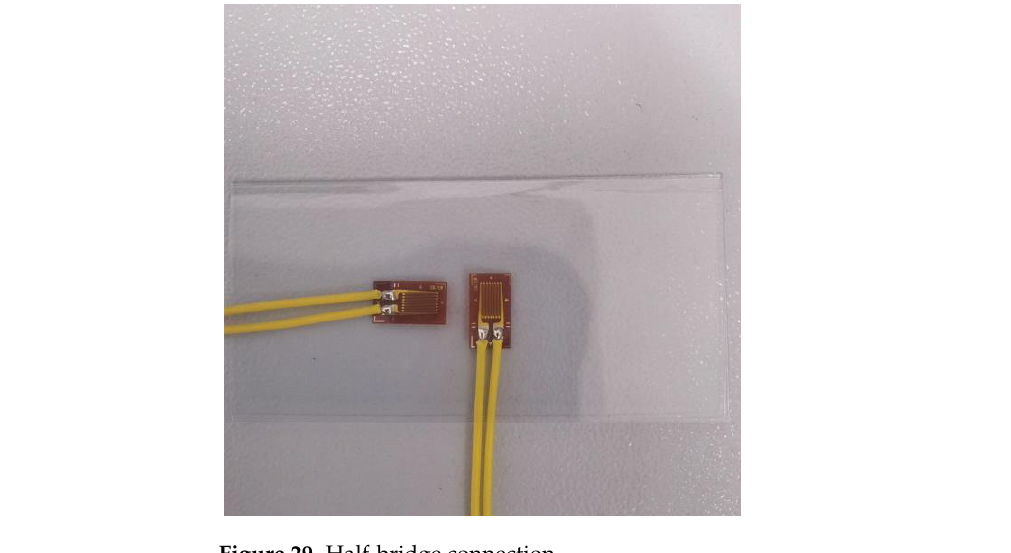
Figure 28. Pasting position of strain gauge.